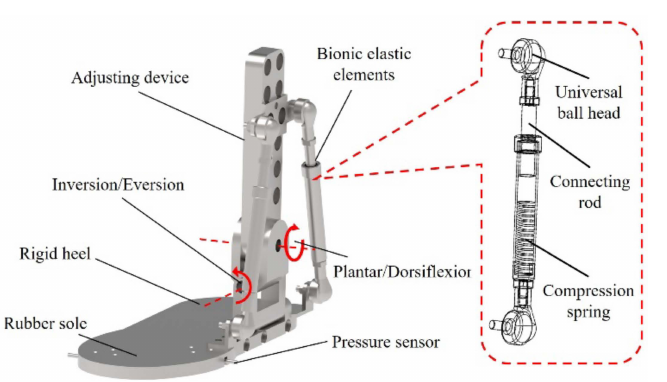
Figure 13. Range of freedom of ankle joint.